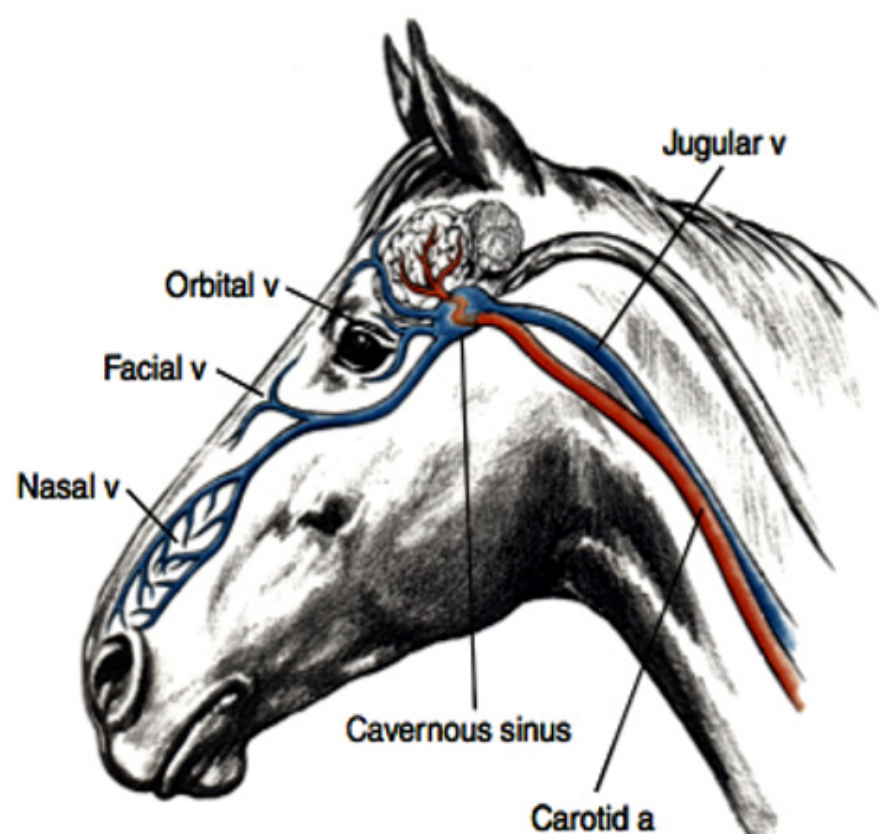
Figure 3. Diagram showing the anatomical arrangement for evaporative respiratory heat loss. The complex system of turbinate bones in the upper respiratory tract is covered by a mucous membrane with a rich blood supply and numerous AVAs, so that when blood enters the nose on inhalation it is cooled and, when necessary, gains direct access to the venous side of the circulation via the AVAs. Venous transporters such as the angularis occuli referred to as orbital vein in this diagram, drain the face and scalp and flow into the cavernous sinus at the base of the brain. The facial vein transports cooled blood from the upper respiratory tract directly into the jugular vein, thence to the right heart and central circulation, effectively contributing to whole body cooling. Diagram with permission from Dr. Finola McConaghy, PHD thesis 1995. (Blue represents venous blood; red represents arterial blood).